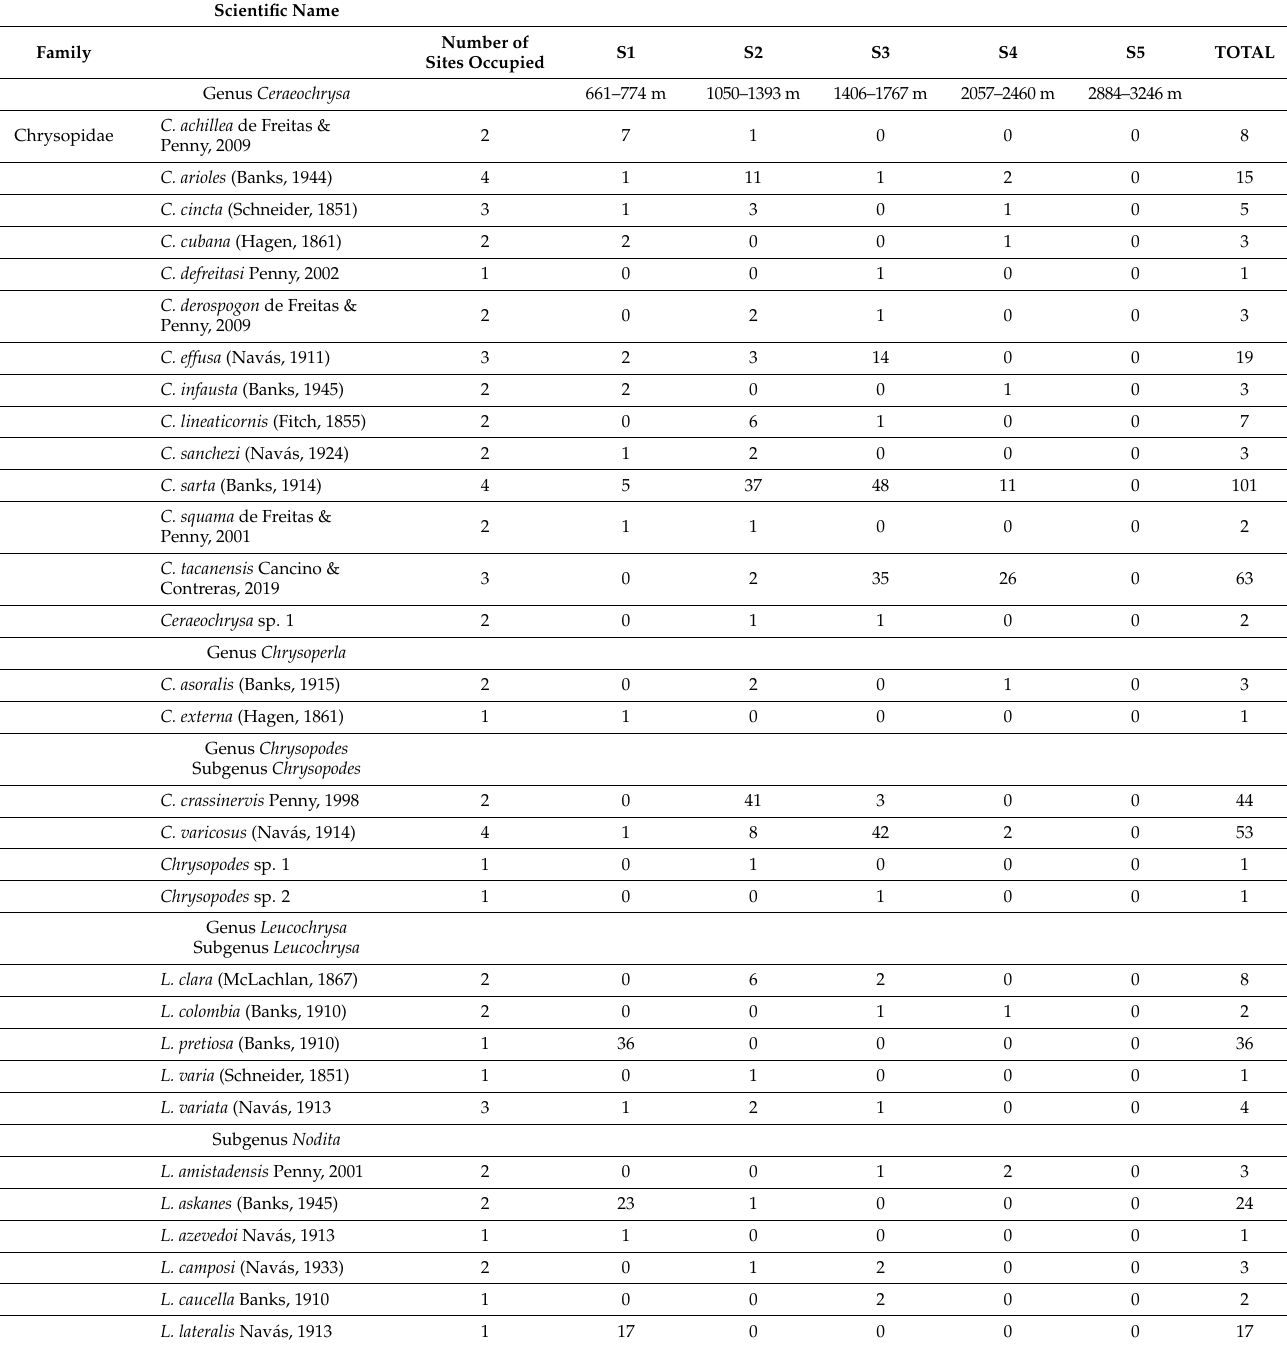
Table 1. List of species of Neuroptera, number of sampling sites where the species was found, and abundance at each sample site along the altitudinal gradient at the Tacan á Volcano, Mexico. S1–S5: Site 1 to Site 5, where S1 has the lowest and S5 the highest altitude. * Species previously identified as Ululodes sp.1 (Adapted with permission from Cancino et al. [39]. Copyright 2021, by the